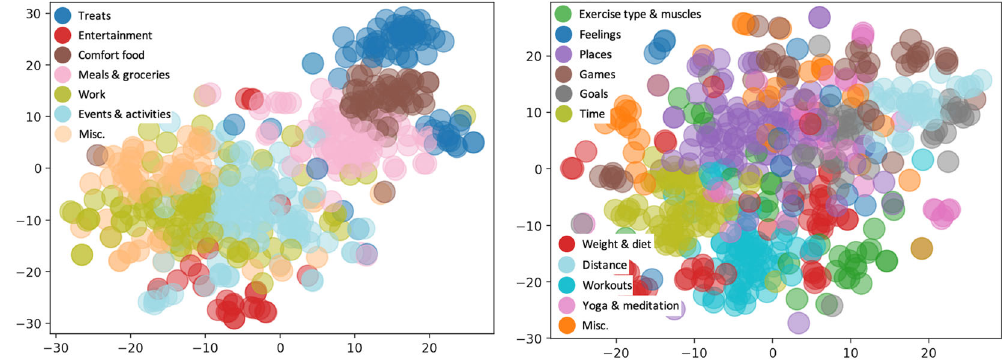
Fig. 7 Clusters for ENJOY THE MOMENT (left) and EXERCISE (right). The former refers to happiness, mainly, as a form of entertainment and recreation. The latter represents happy moments as based on bodily and physical care.